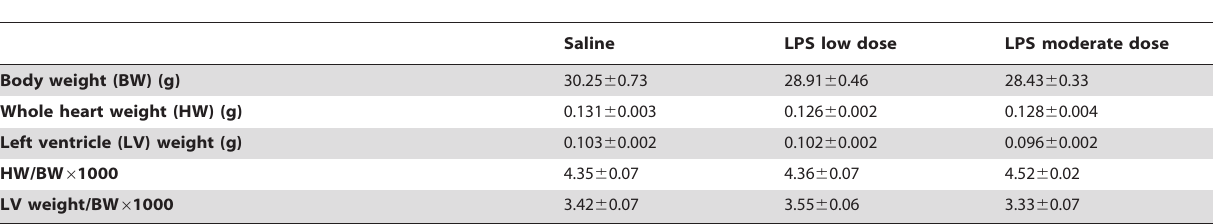
Table 2. Heart and body